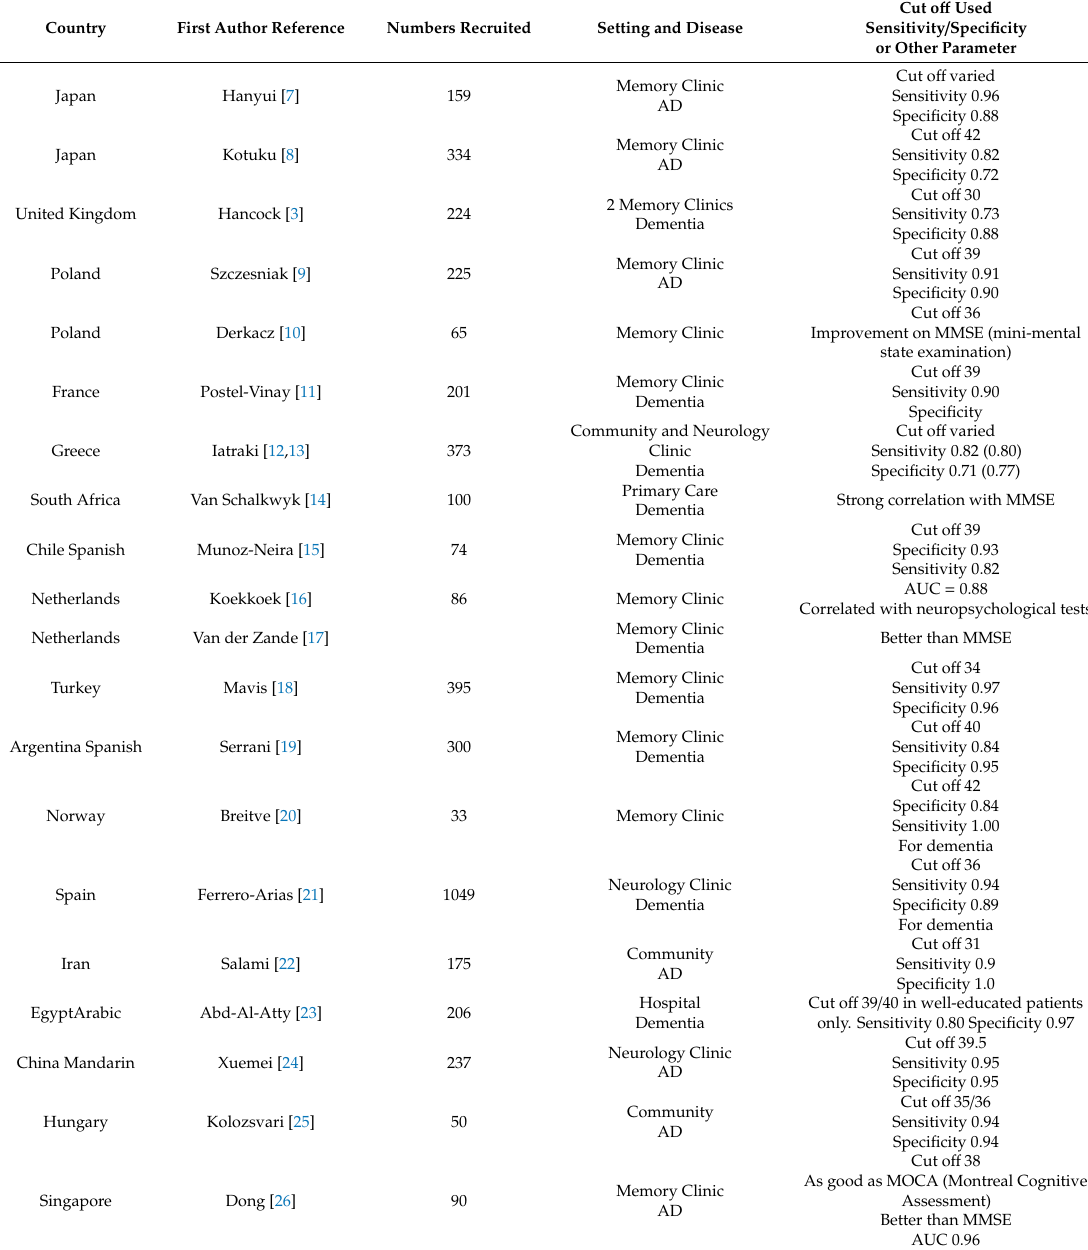
Table 1. Summary of TYM validation